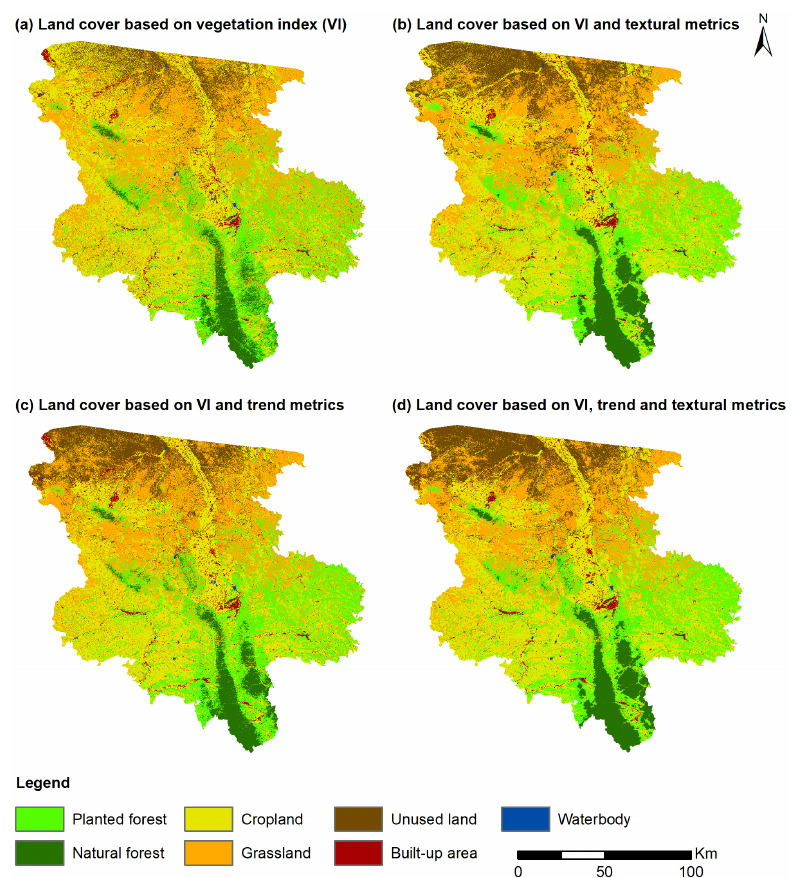
Figure A2. Land cover types classified based on the algorithm considering ( a ) the vegetation index (VI), ( b ) VI and textural metrics, ( c ) VI and long-term change trend metrics, and ( d ) VI, long-term change trend and textural metrics . Table A1. Vegetation indices considered in this study.